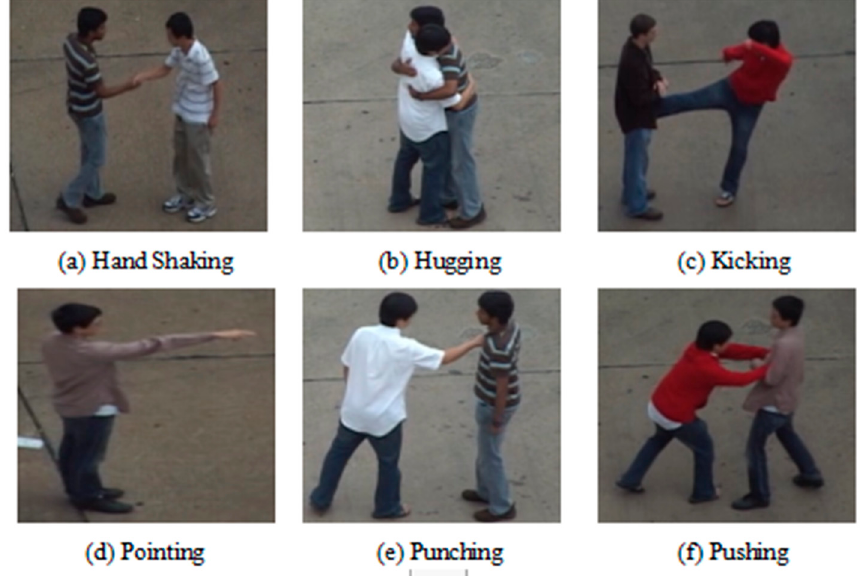
Figure 8. Example of UT set 1 dataset.